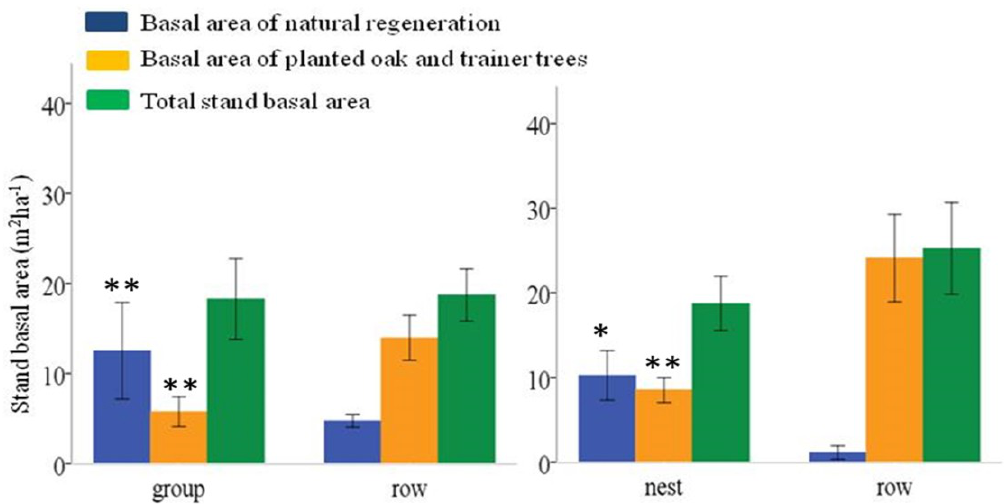
Figure 4. Comparison of stand basal area among nest, group and row planting. * p < 0.05 level, ** p < 0.01 level. Lines denote standard error at 95% confidence